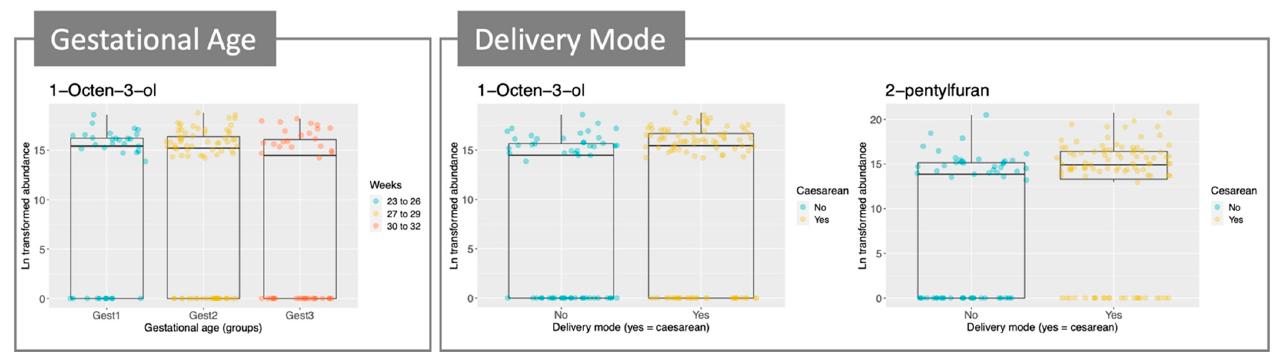
Figure 3. Boxplots for a selection of compounds (abundance/gestational age and delivery mode). Each boxplot represents a compound, and these are grouped according to the variable of interest (gestational age and delivery mode). All samples were included, n = 152.